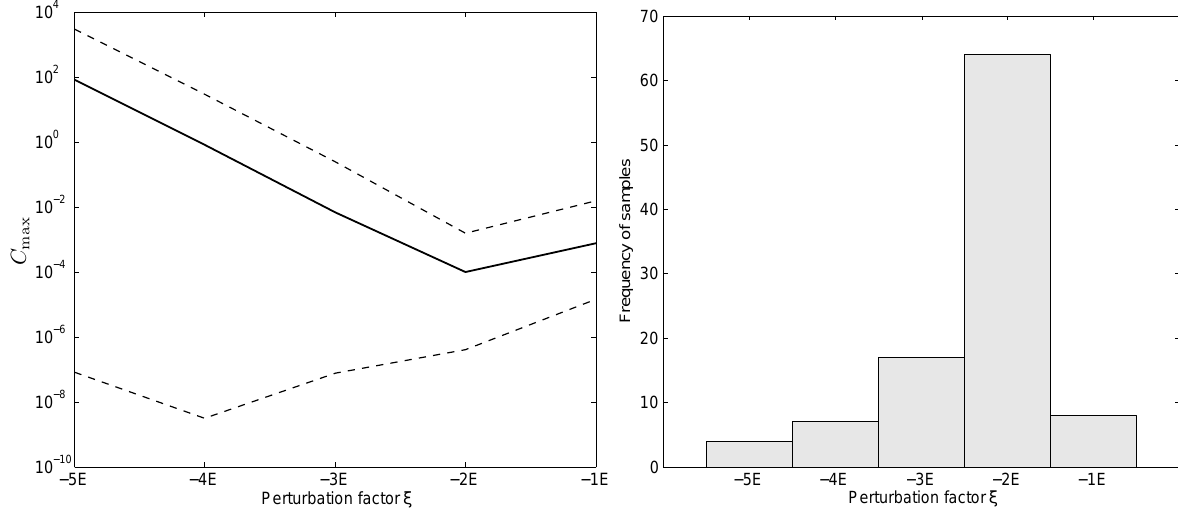
Fig. 4. The mean (full line), minimum and maximum (dotted lines) values of C max as a function of the perturbation factor ξ (a) and the frequency distribution of the optimal perturbation factor (b) , for 100 sampled compositions.